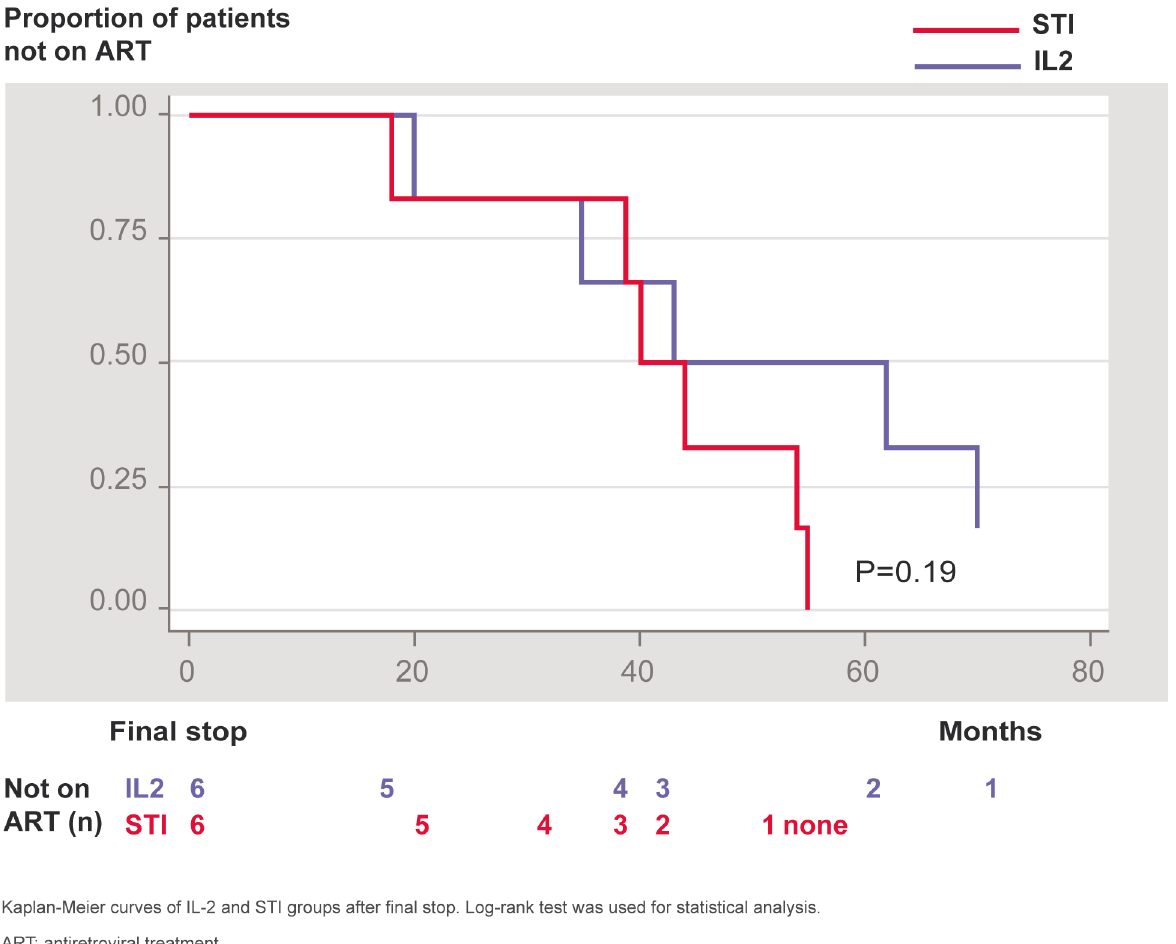
Fig 4. Proportion of patients not receiving ART after the final stop.